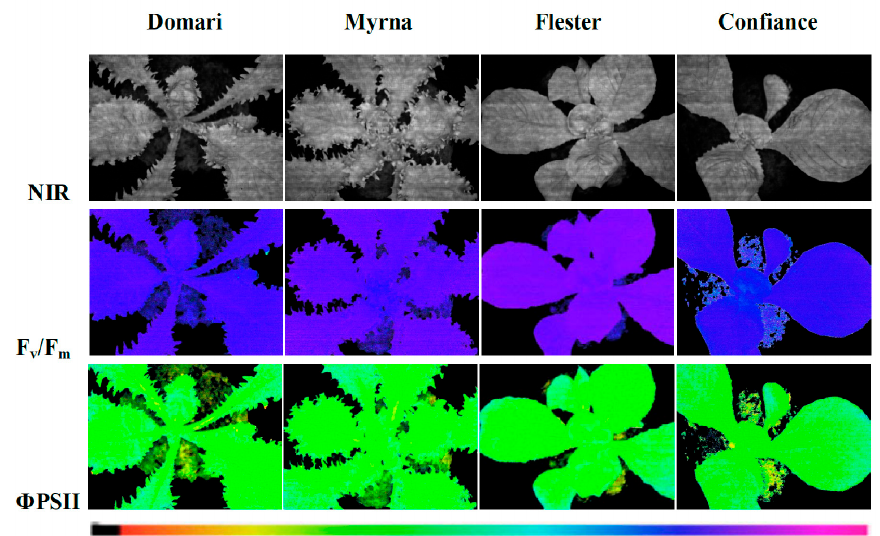
Figure 6. Images of chlorophyll fluorescence parameters in leaves of endives (cv ‘Domari’ and ‘Myrna’) and escaroles (cv ‘Flester’ and ‘Confiance’) cultivars grown under greenhouse conditions. Near-infrared images (NIR) of representative leaves, maximal quantum e ffi ciency (F v / F m ) measured in dark adapted leaves and quantum e ffi ciency of PSII photochemistry ( Φ PSII) measured at steady state with light intensity of 370 µ mol photons m − 2 s − 1 are shown using an Imaging-PAM M-series system. The false colour code depicted at the bottom of the images ranges from 0.000 (black) to 1.000 (pink).